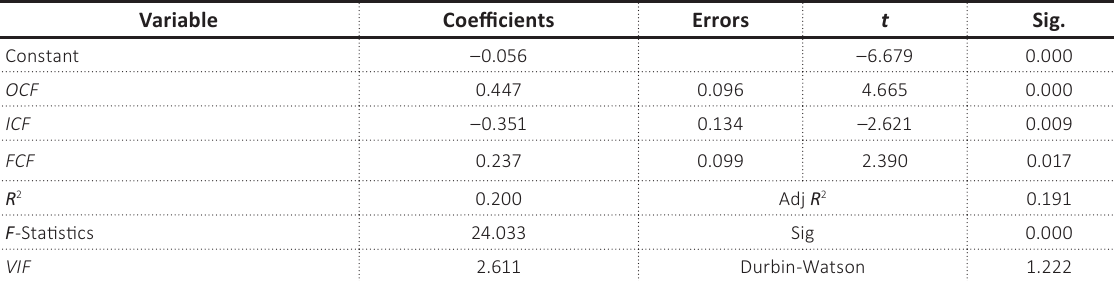
Table 5. OLS regression results (small